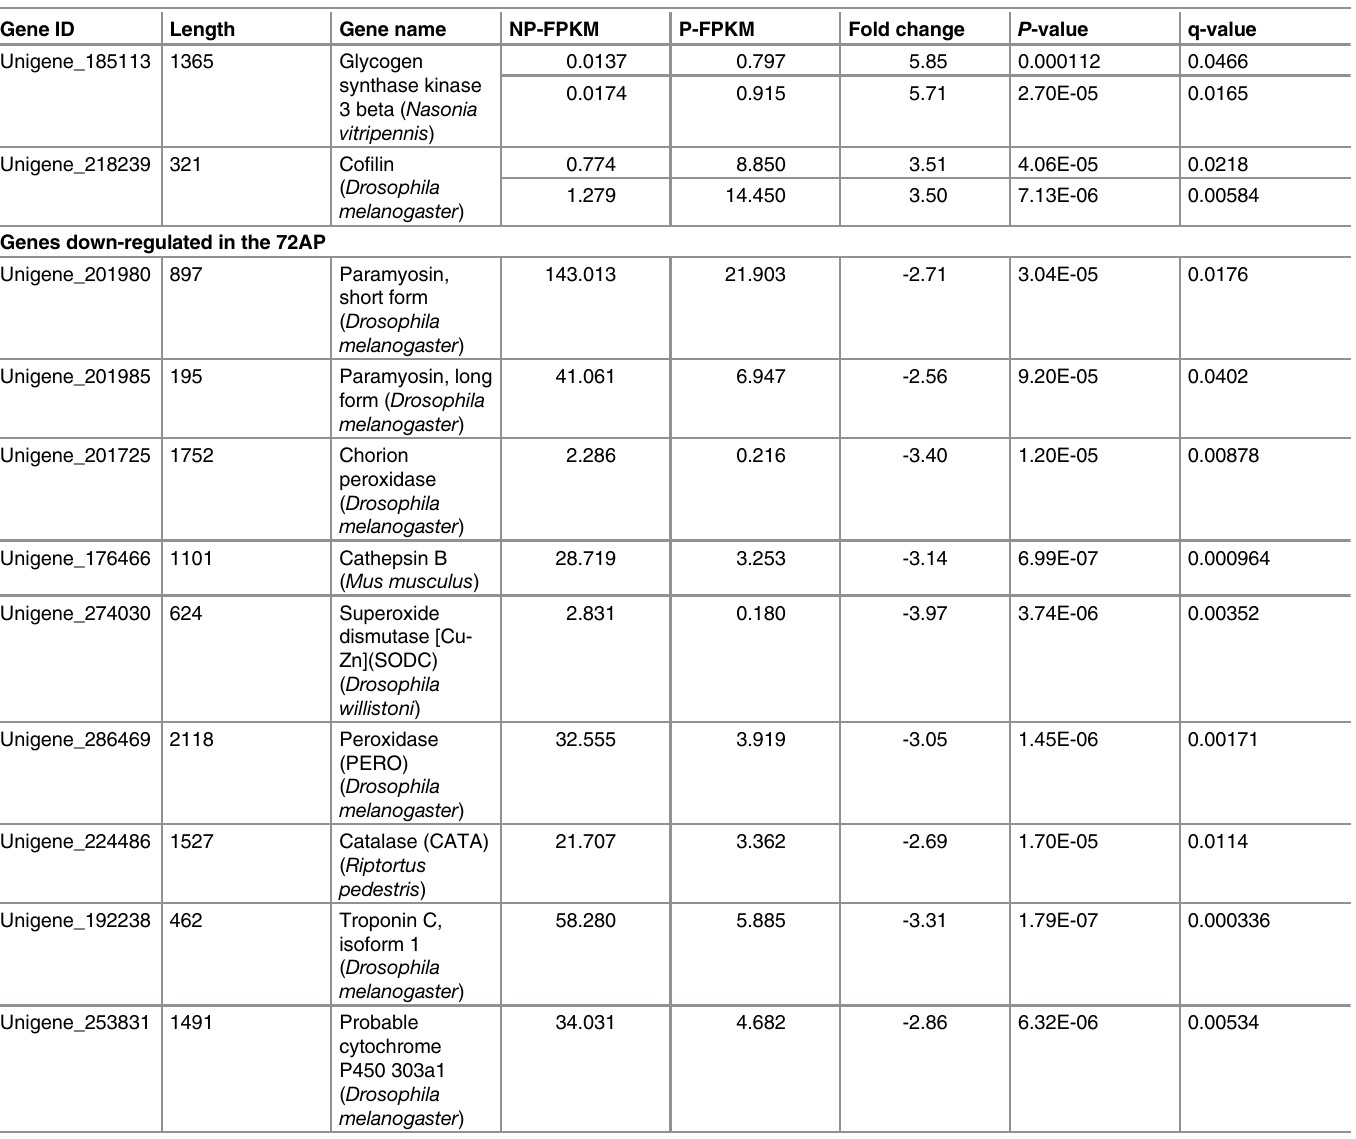
regulated in parasitized B . tabaci nymphs and P . xylostella larvae [26,59], while Etebari et al . [41] discovered that serpins were up-regulated 2- to 7-fold after P . xylostella parasitization by Diadegma semiclausum . In C . chilonis parasitized C . suppressalis , three up-regulated and three down-regulated serpins were identified in the fatbody [42]. Different serpins may play different roles in immune